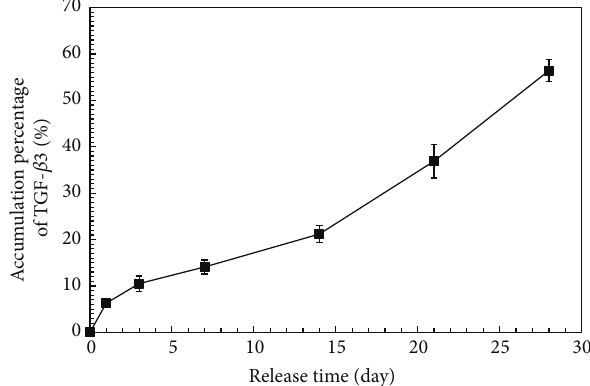
Figure 3: Release kinetics of the TGF-b3 from the PLGANPs. Data were expressed as means ± SD ( 𝑛 = 3